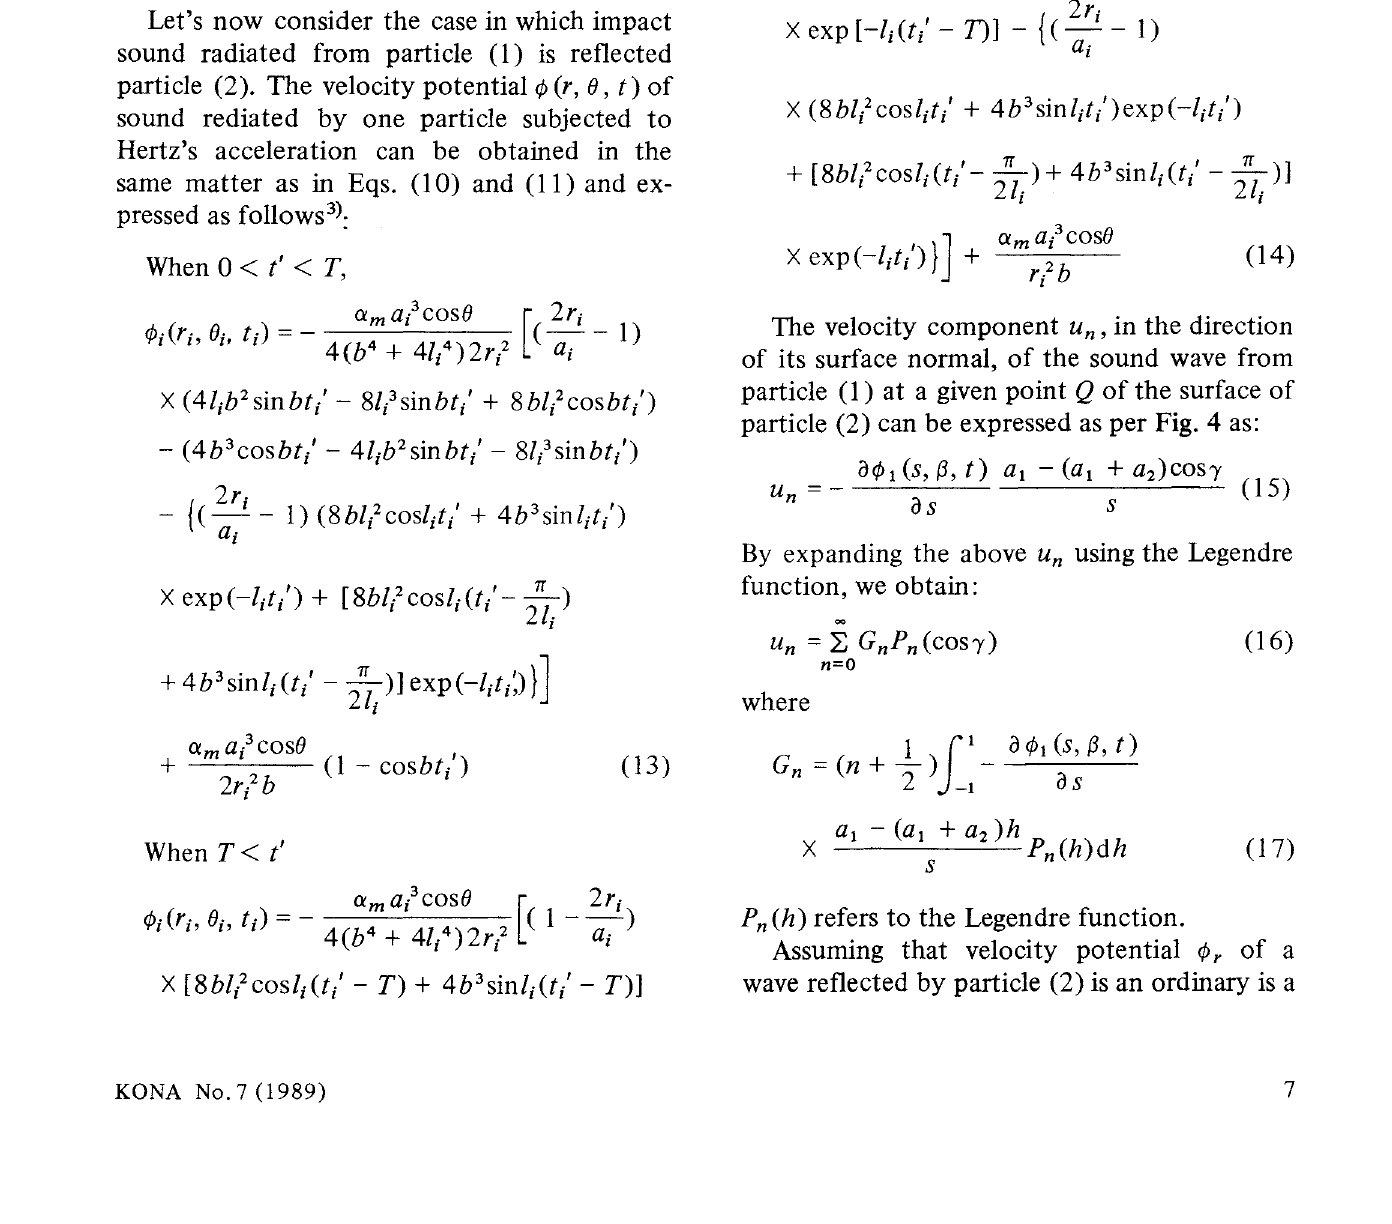
Fig. 4 Reflection of the impact sound from colliding